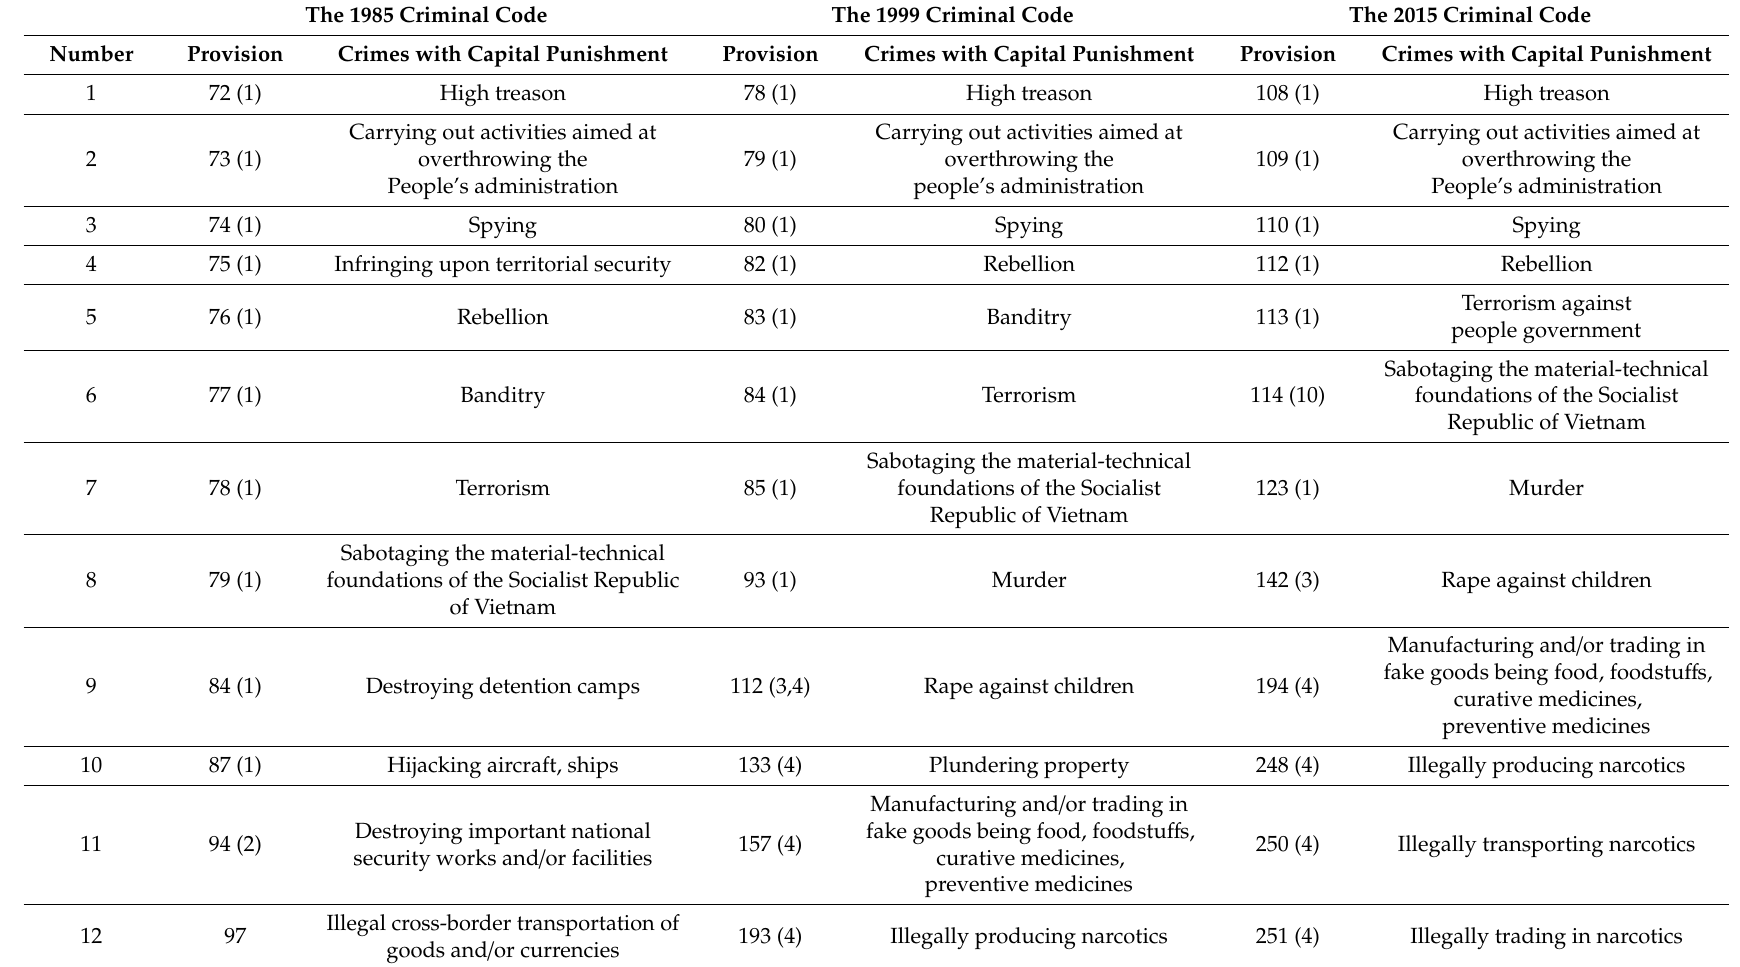
Table 1. Capital Crimes in the 1985, 1999 and 2015 Criminal